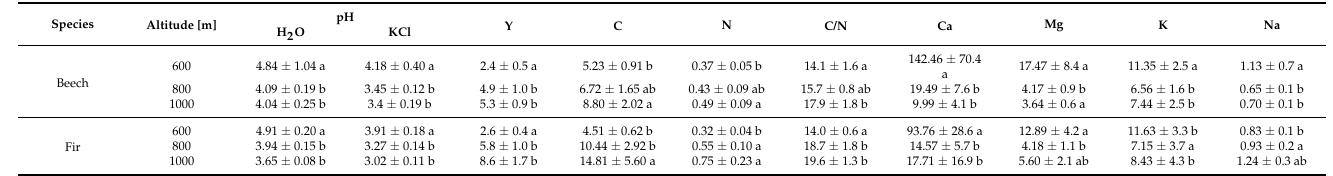
Table 1. Chemical properties of study soils under influence of different species in altitude gradient.